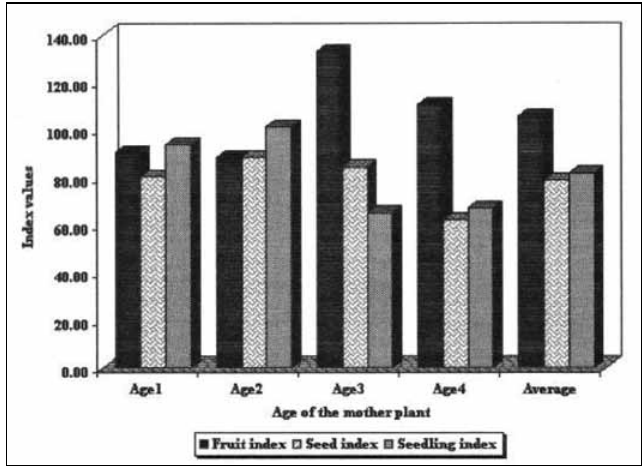
Fig. 1 - Fruit, seed and seedling index of four age groups in mangosteen ( Garcinia mangostana